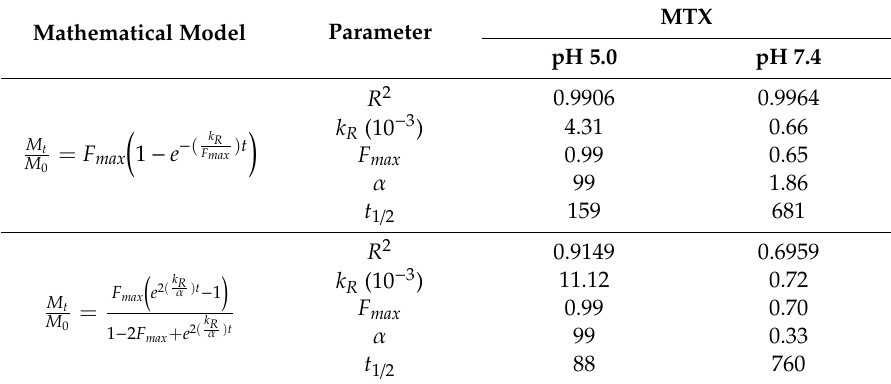
Table 1. R 2 values and kinetic parameters for mathematical modelling of MTX release.